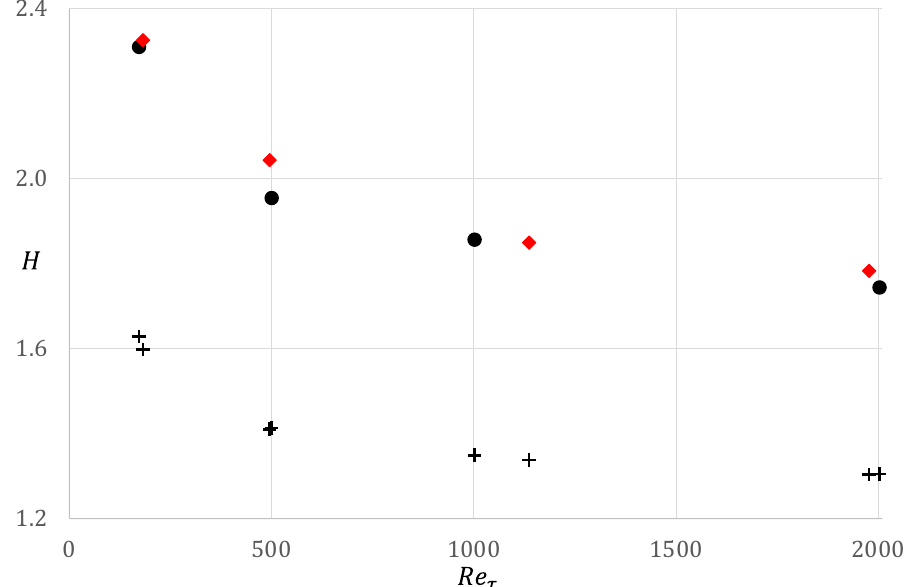
2000 ; • pipe DNS data [26]; pipe DNS data [31,32]; and + ♦ 𝐻𝐻